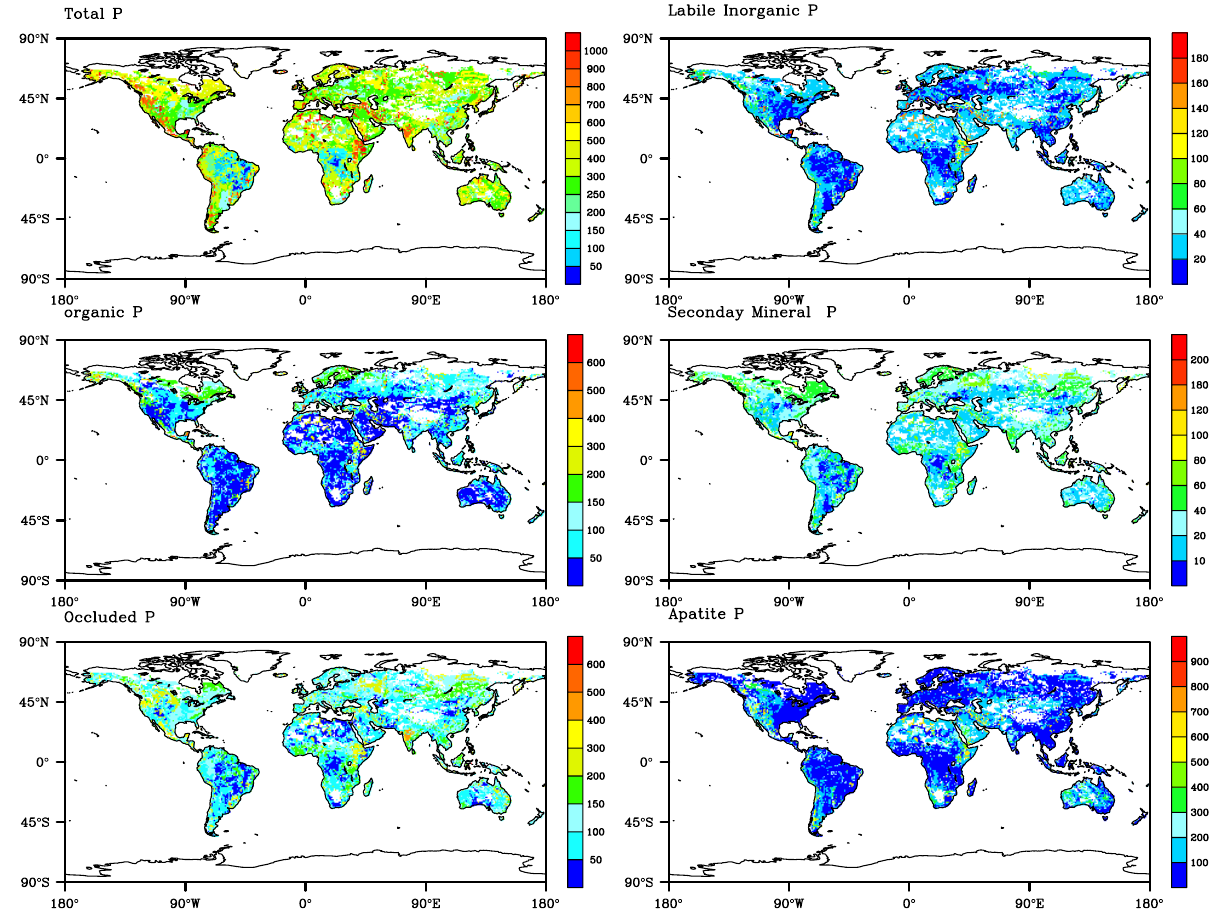
Fig. 3. The distributions of different forms of soil P, each with different accessibility for plant and microbial use (unit: gPm − 2 , please note that different color bars are used for the different maps)